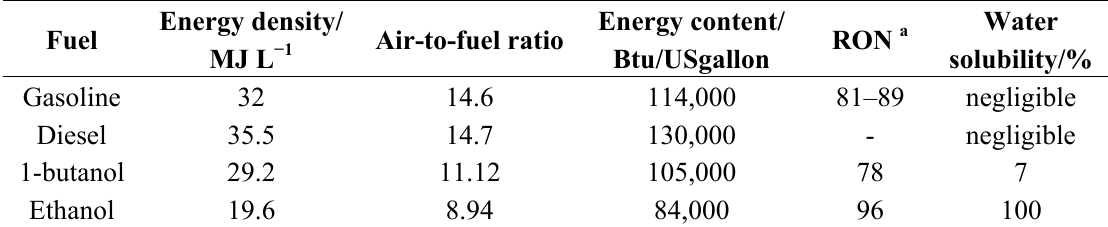
Table 1. Chemical and physical properties of gasoline, diesel, 1-butanol and ethanol. Data is reproduced from reference